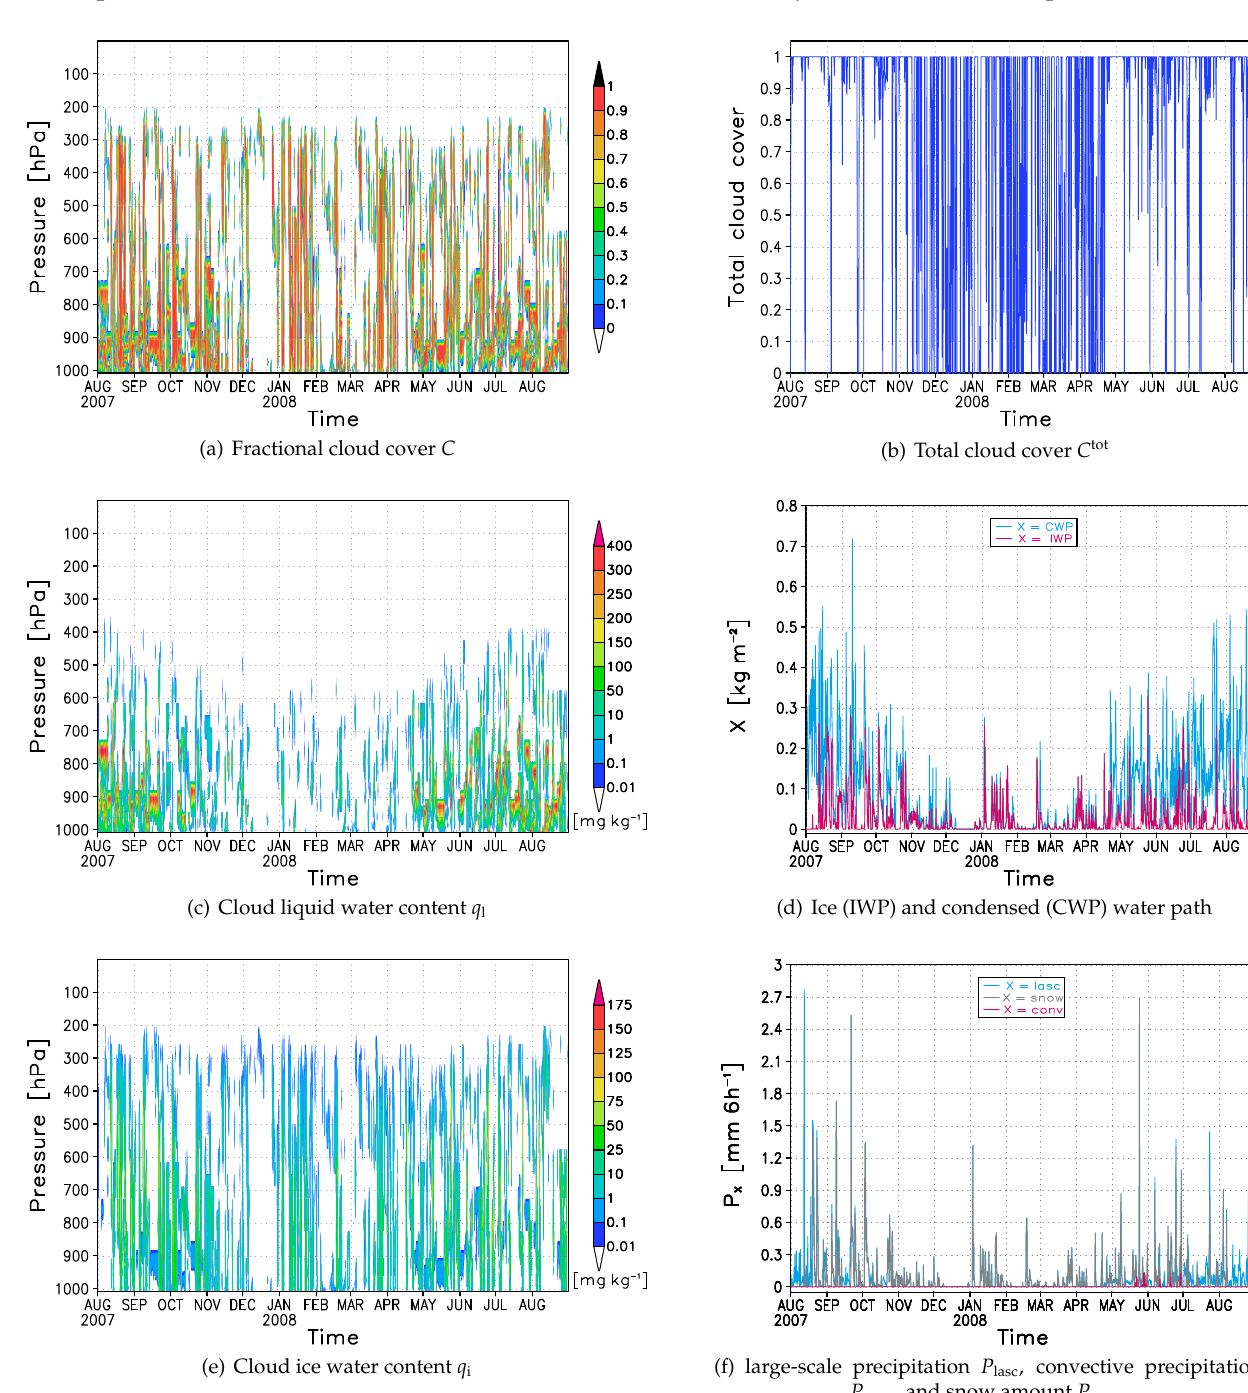
Figure 3. Simulated fractional ( a ) and total ( b ) cloud cover, cloud liquid ( c ) and ice ( e ) water content, ice and condensed (sum of liquid and ice water paths) water path ( d ) as well as large-scale and convective precipitation and the contribution of snow ( f ) for the period from 1 August 2007 to 31 August 2008. This HIRHAM5-SCM reference run was conducted at the NP-35 start position ( 102 . 81 ◦ E, 81 . 40 ◦ N) using the PS-Scheme and applying default model parameters (see Table 1). The results are shown as 6-hourly standard model